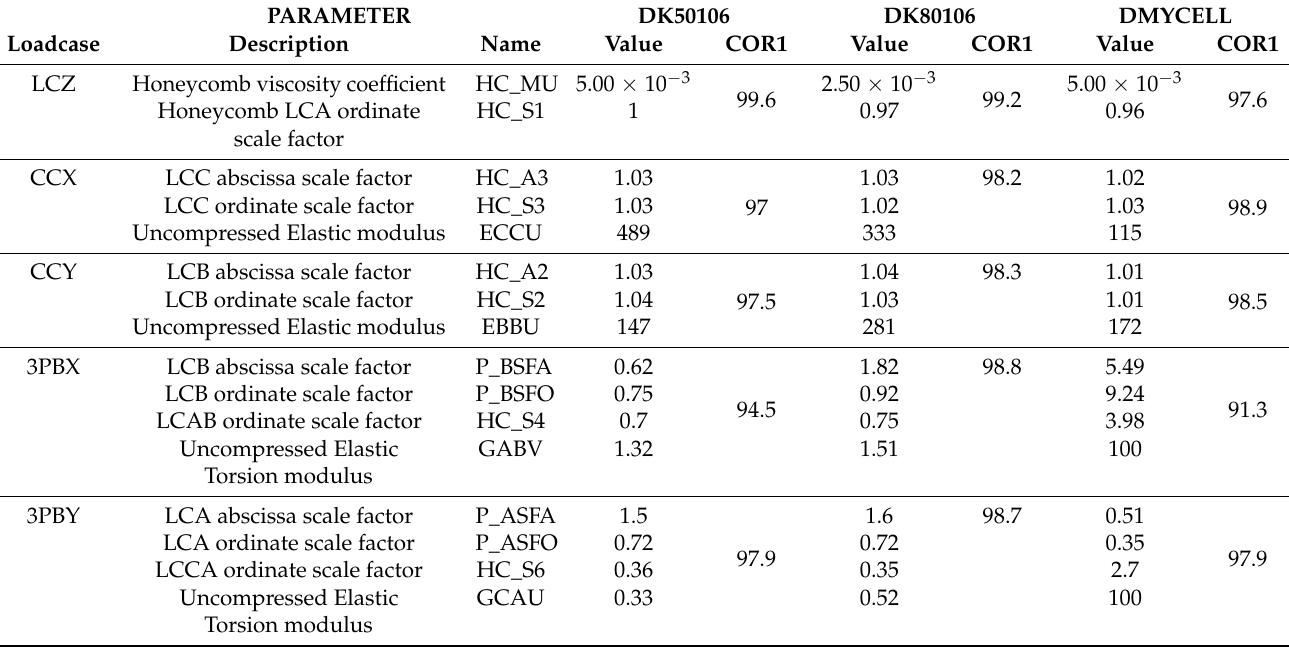
Figure 3. Calibration process of the Pouch Cell Macro FE model for five load cases. Table 2. Calibration parameters for each cell type tested.